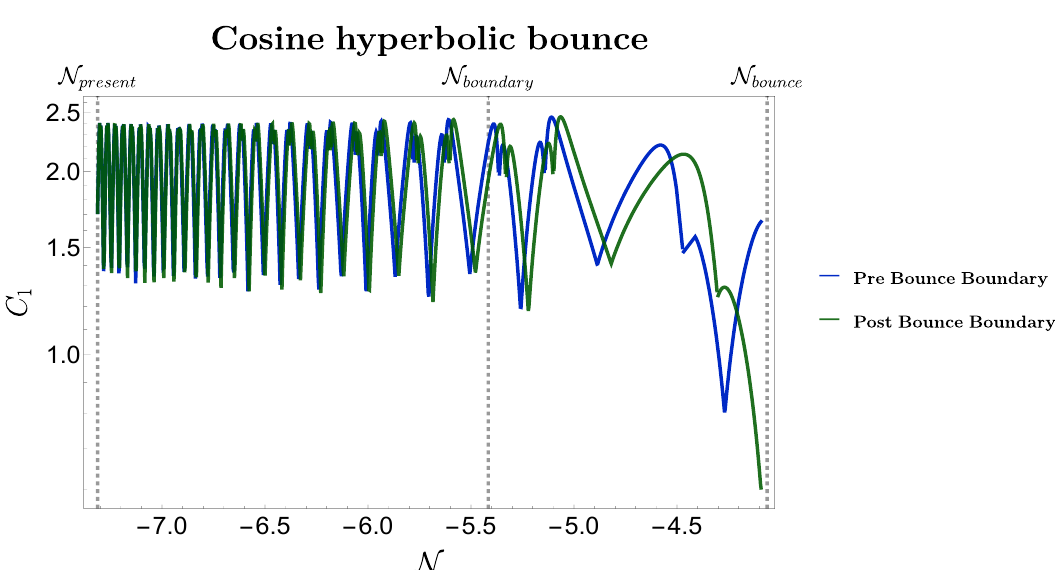
Figure 19: Variation of linearly weighted complexity outside bouncing region with respect to number of